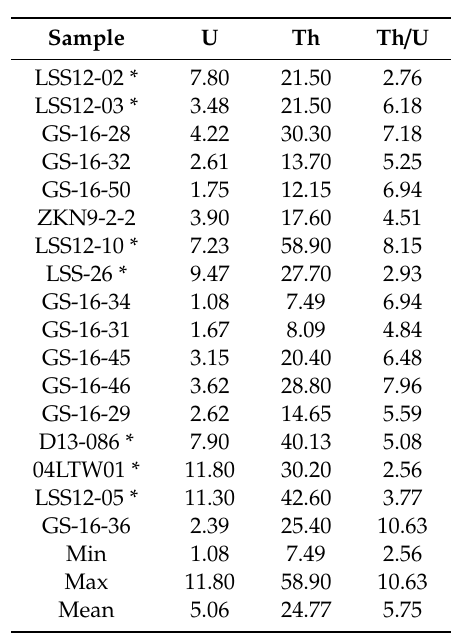
Table 3. The U, Th contents and the ratios of Th / U of the Jiling